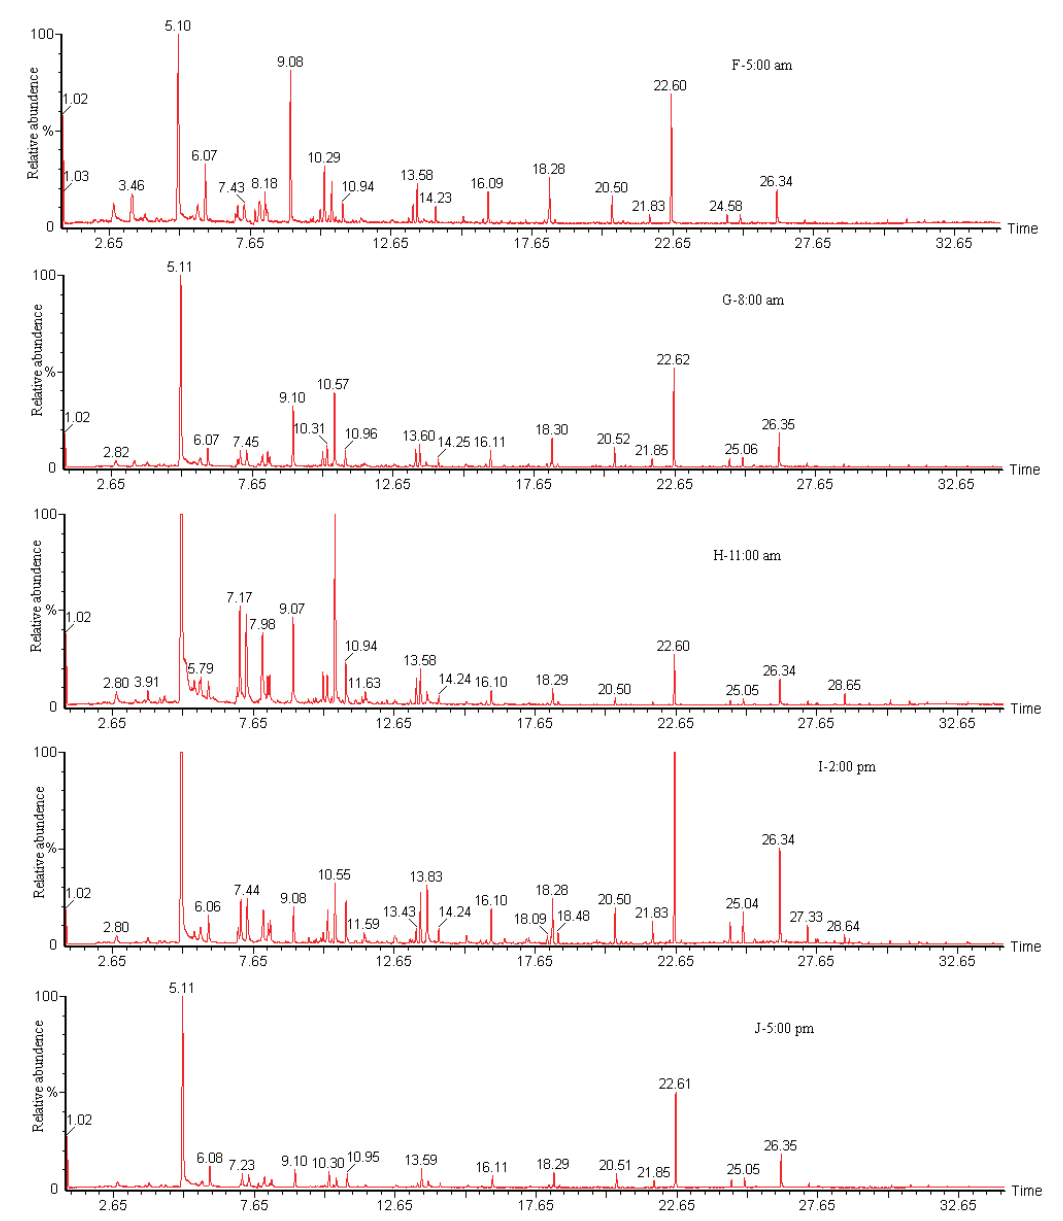
Fig. 2: GC/MS total ion current chromatograms of volatile compounds from four seasons rose in cloudy day